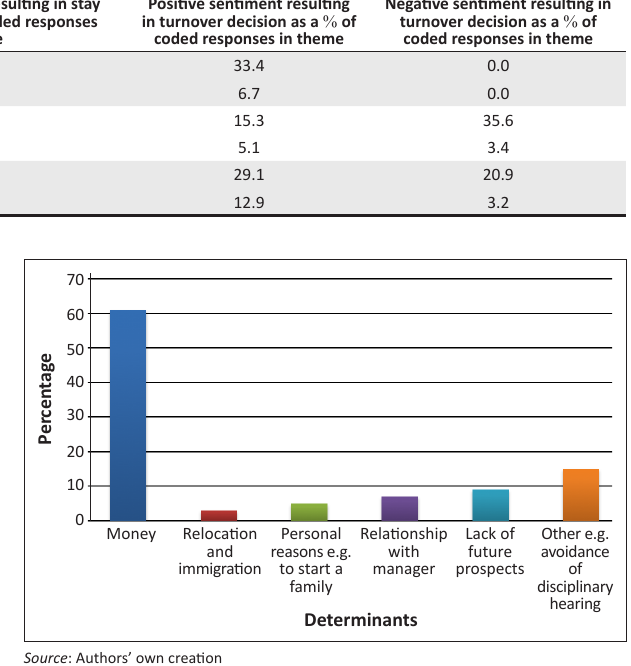
FIGURE 1: Determinants of turnover from exit interview